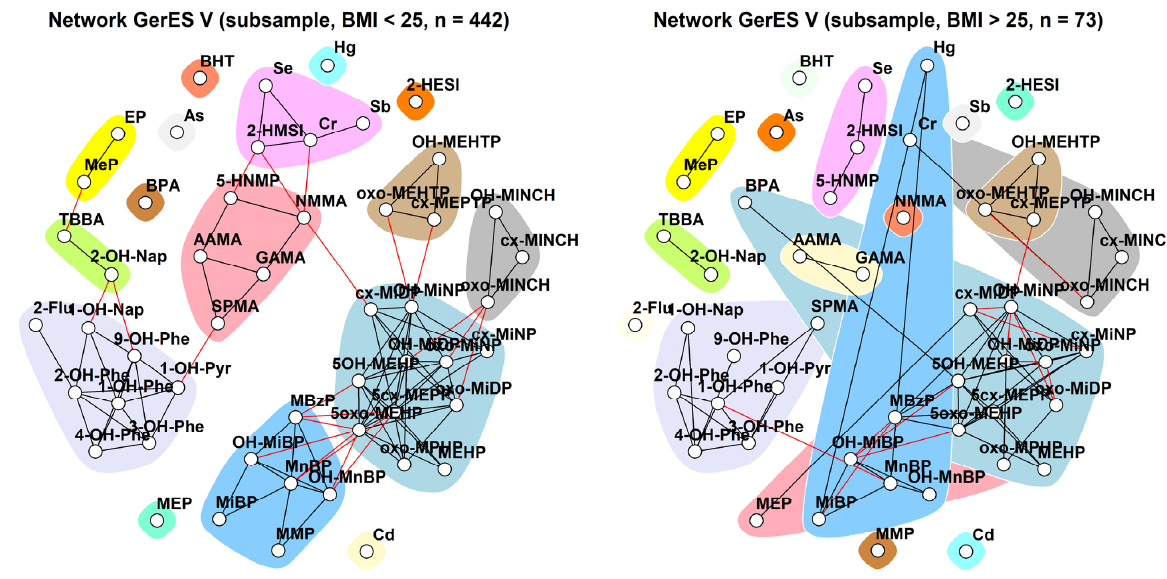
Figure 13. Stratification of the network for the GerES V subsample by BMI, using creatinine-standardised and creatinine-adjusted data. Data were corrected for sex, smoking status, age, and ISCED. Black lines indicate dependency between nodes (biomarkers) within a community; red lines indicate dependency between nodes in different communities.